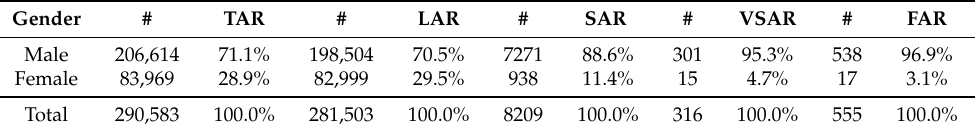
Table 3. Gender of workers.